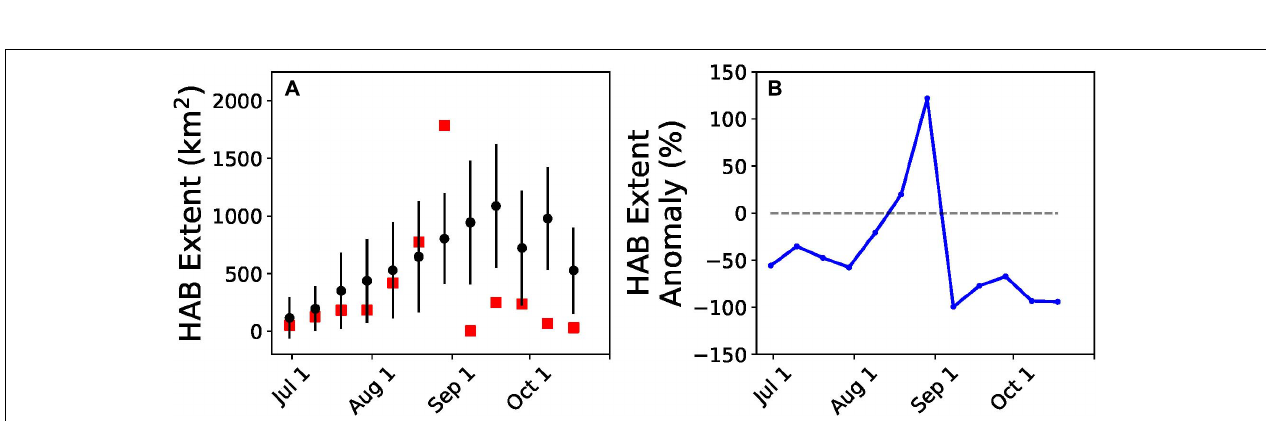
FIGURE 6 | Median basin-wide anomalies for the 10-day windows starting from March 1 to December 26. Windows in which less than 50% of the regional data pixels have data are excluded. (A,D,G) The CHL, TSS, and PZD anomaly time series for WBLE. (B,E,H) The CHL, TSS, and PZD anomaly time series for SBLH. (C,F,I) The distribution of CHL, TSS, and PZD anomalies in both basins from March through December.